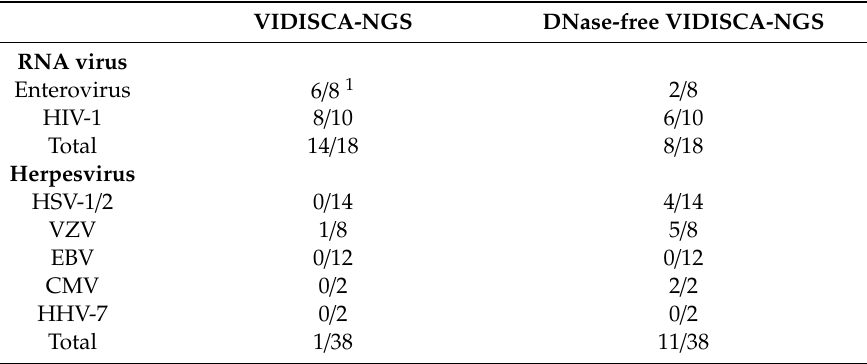
Genes 2019 , 10 , 332 6 of 12 HSV-1: herpes simplex virus 1, HSV-2: herpes simplex virus 2, VZV: varicella-zoster virus, EBV: Epstein-Barr virus, CMV: cytomegalovirus, HHV-7: human herpes virus 7, HIV-1: human immunodeficiency virus 1. Next, we hypothesized that the nuclease treatment may have hampered the detection of herpesvirus DNA. DNase treatment is done prior to nucleic acid extraction to remove naked chromosomal and bacterial DNA. It is assumed that viral genomic DNA is protected from DNase by the virus particle, however, if viral DNA is non-encapsidated, it will also be degraded. We therefore